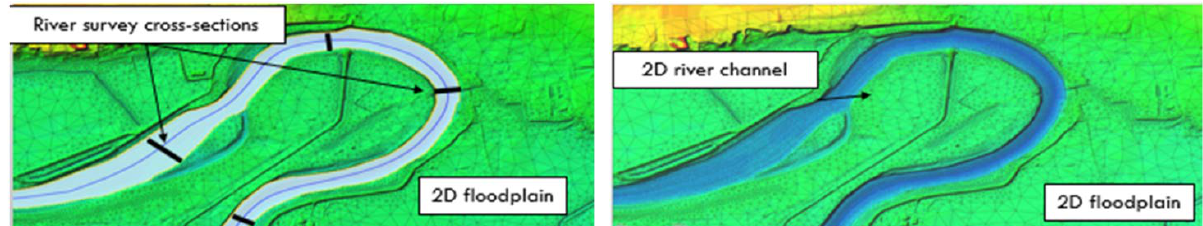
Figure 4. Creation of 1D and 2-dimensional ( 2D ) river and floodplain models.